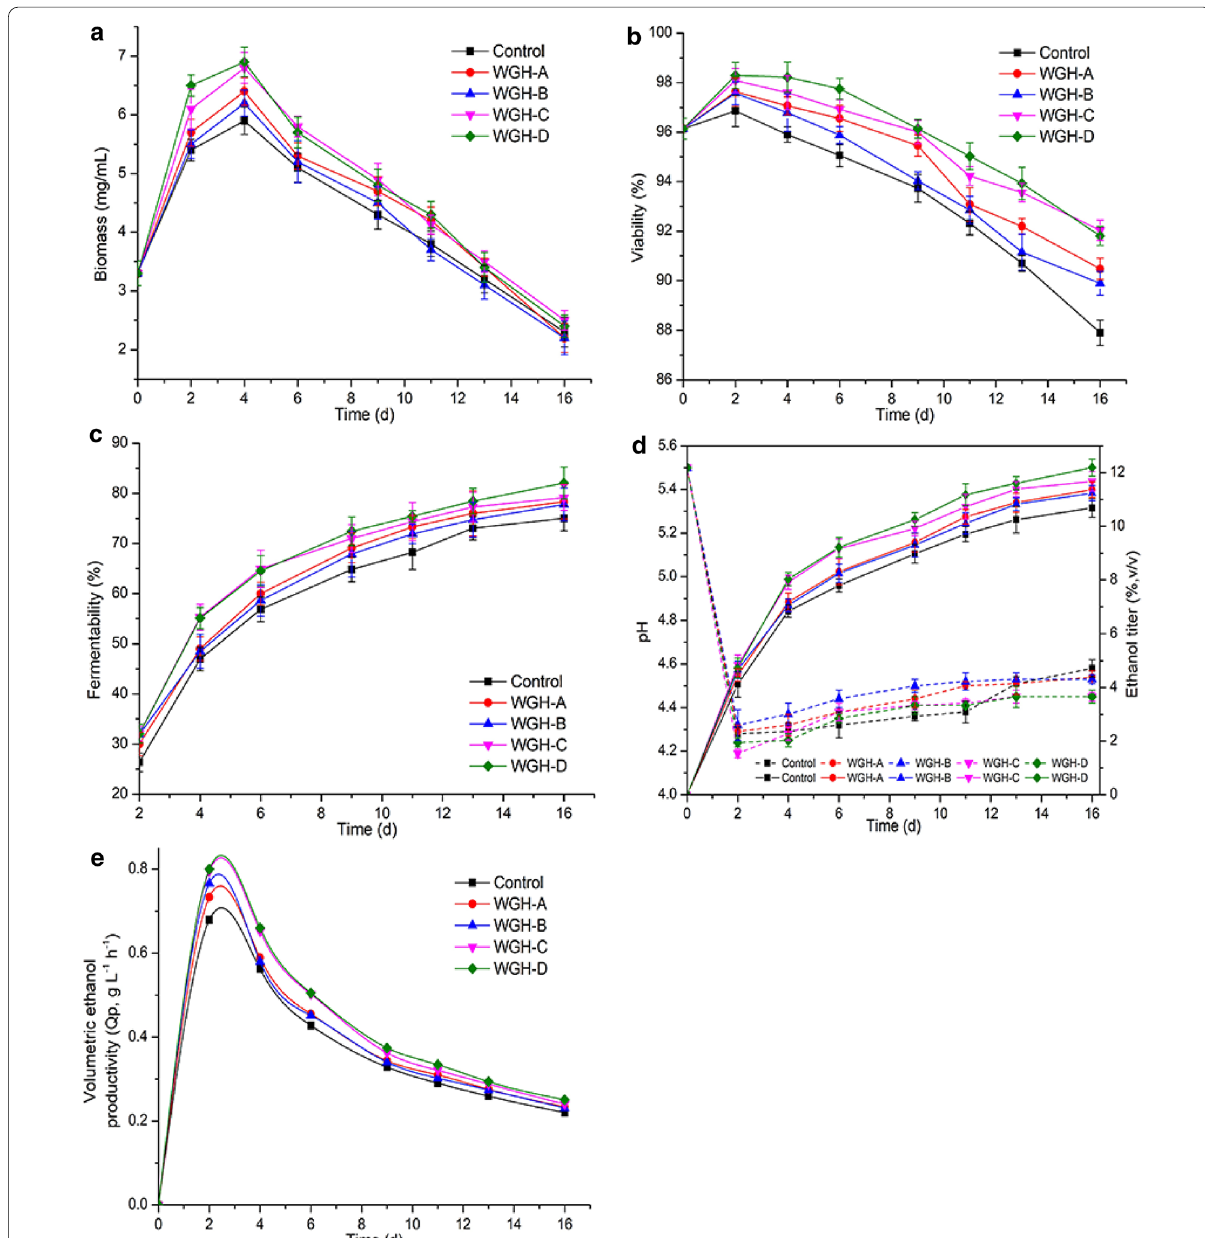
Fig. 1 Effects of WGH-A, WGH-B, WGH-C and WGH-D additions on the biomass ( a ), viability ( b ), fermentability ( c ), pH (dashed) and ethanol yield (solid) ( d ) and ethanol productivity ( e ) during VHG fermentation. WGH-A, supernatant of wheat gluten hydrolysate; WGH-B, WGH-C and WGH-D, 0, 20 and 40% ethanol elution fractions of WGH-A on XAD-16 resin, respectively. Error bars indicate the standard deviations from three independent